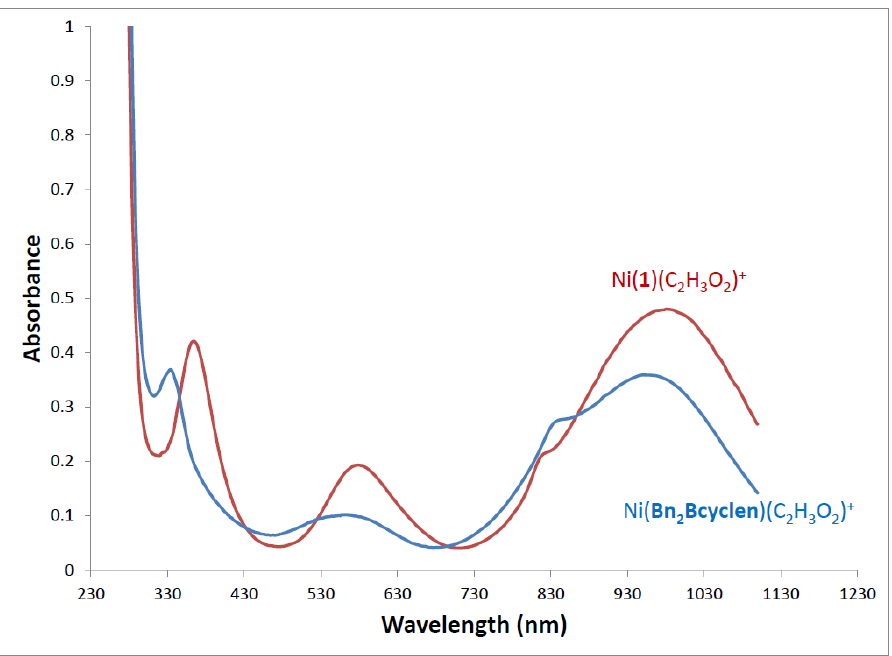
Figure 14. UV-Visible spectra of Ni( Bn 2 Bcyclen ) and Ni( 1 ) in acetonitrile at 0.010 M.